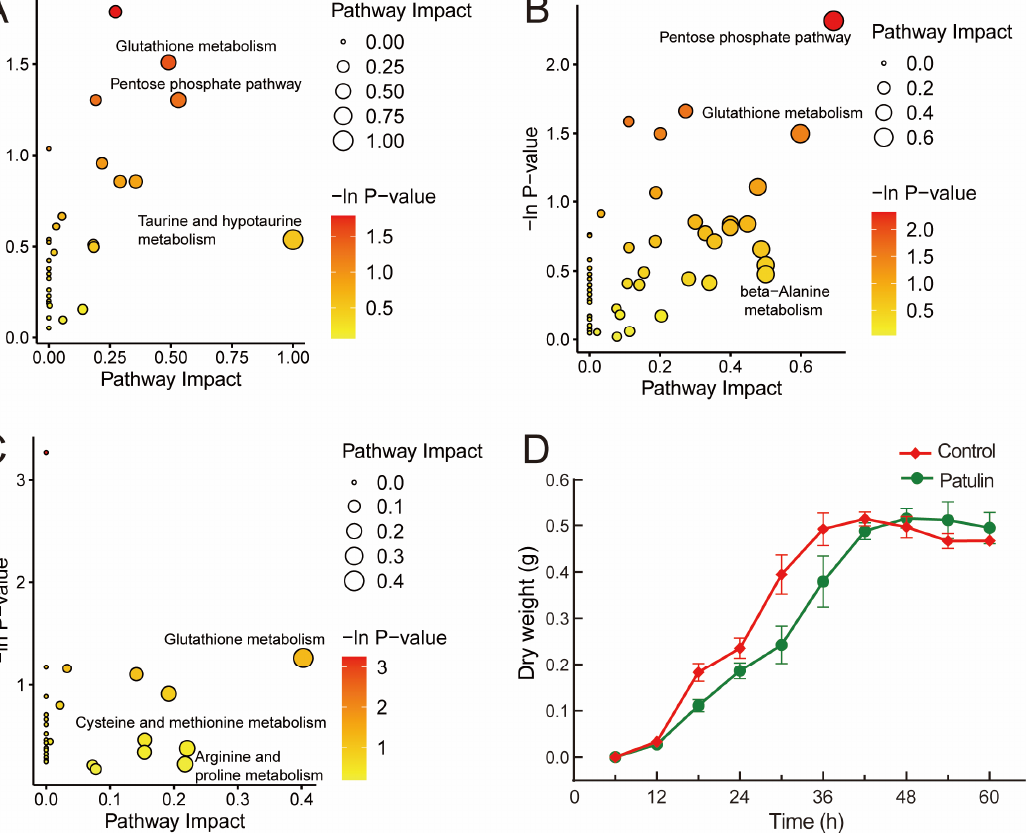
Figure 5. ( A – C ) constitute the pathway analysis of the identified metabolites affected in the patulin treatment groups. Significantly changed pathways based on enrichment and topology analysis are shown. The x -axis represents the pathway impact, and the y -axis represents pathway enrichment. The timepoints of the pathway enrichment analysis of A. niger FS10’s metabolites are as follows: ( A ) 24 h; ( B ) 36 h; ( C ) 48 h. ( D ) shows the growth curve of A. niger FS10. The red curve represents the control group, while green curve represents patulin treatment group.